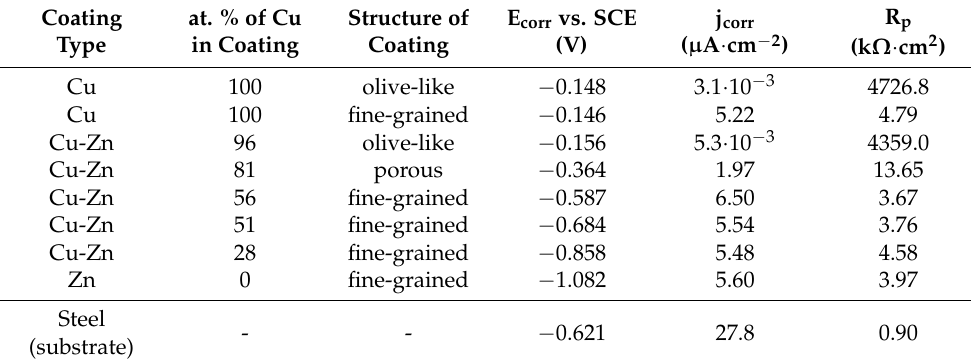
Figure 15. Potentiodynamic curves for the steel substrate as well as for the selected coatings (Cu, Zn, Cu-Zn) with different structure: *—fine grained coatings; (por)—porous coating; (o) —coatings with the olive-like structure. Table 2. Summary of the results obtained by the Tafel potentiodynamic